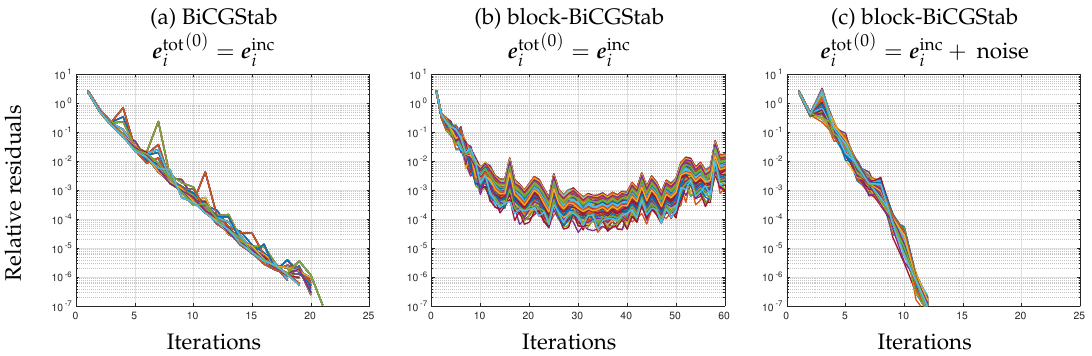
Figure 2. Resolution of 160 forward problems with biconjugate gradient stabilized (BiCGStab) ( a ) and with block-BiCGStab ( b , c ): evolution of the residuals for the 160 iterates. ( a , b ): initialization is set to the incident fields. ( c ) initialization of block-BiCGStab is perturbed with 50 dB circular Gaussian noise. Note the different abscissa scale on panel ( b